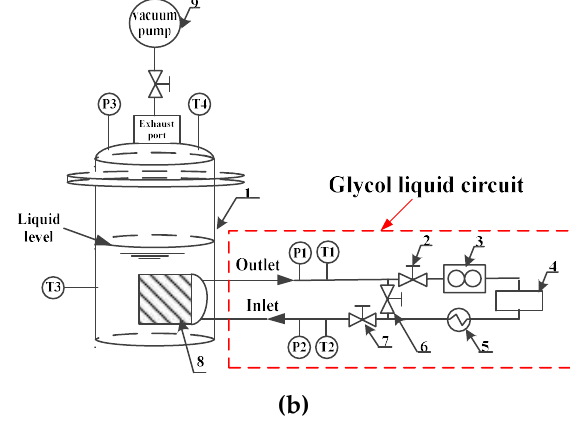
Figure 6. Photo and schematic diagram of experiment system (1—water tank, 2,6 and 7—valve, 3—flowmeter, 4—glycol liquid reservoir, 5—liquid pump, 8—water evaporator ,9—vacuum pump, T1, T2, T3 and T4 are temperature sensor, P1, P2 and P3 are pressure sensor). ( a ) Photo, ( b ) schematic diagram.